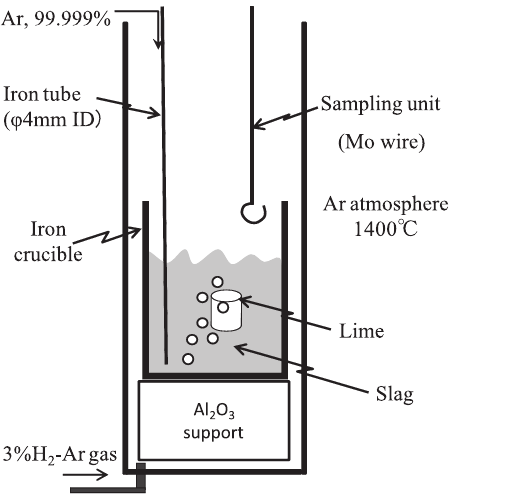
Fig. 4: Schematic diagram of experimental apparatus for evaluating dissolution rate of various limes.